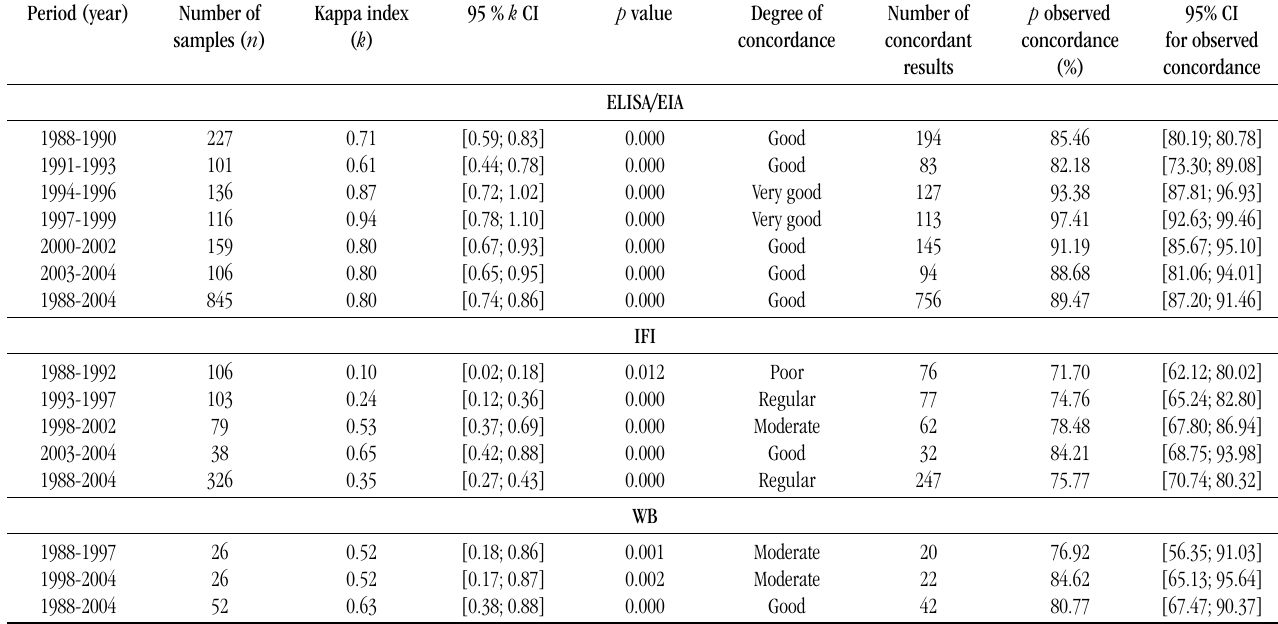
tABLE 1 – Evaluation of reproducibility of the results of serum samples grouped in different time periods in ELISA/EIA, IFI and WB